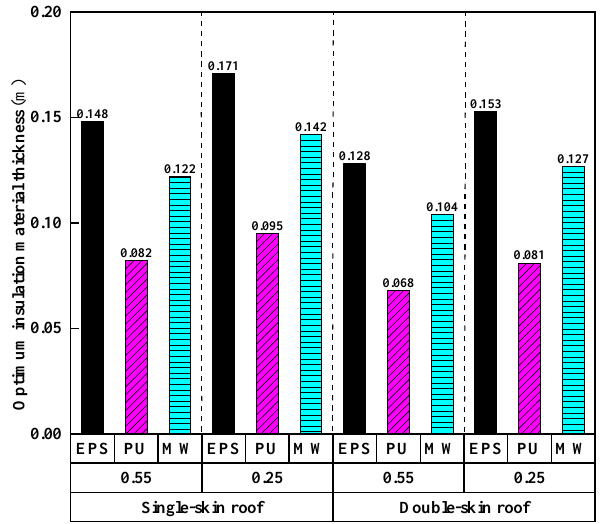
Figure 9. Optimum roof thermal insulation of buildings.